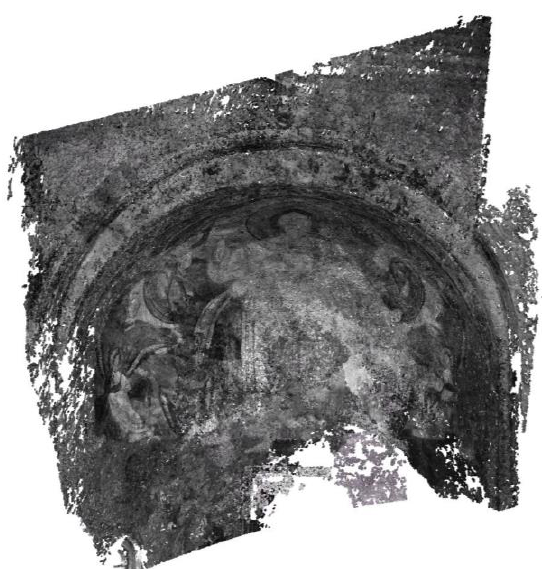
Figure 4. Dense cloud obtained from processed historical